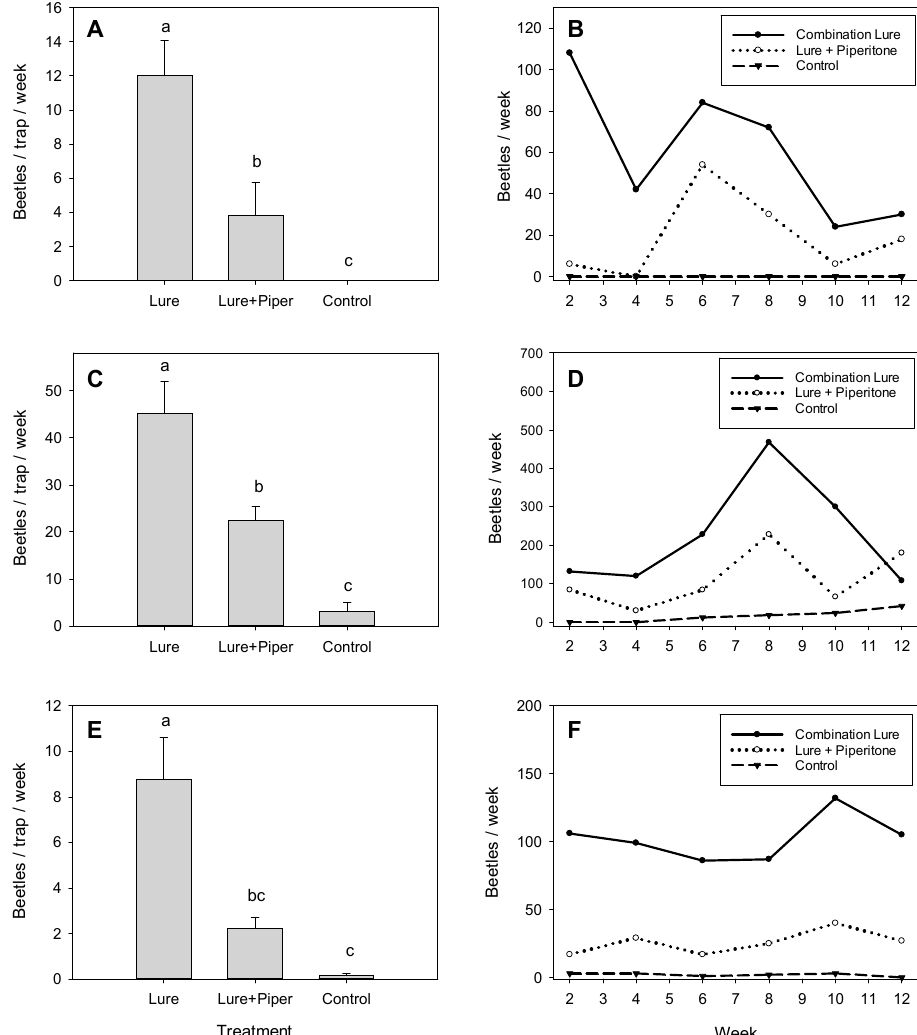
Figure 3. Captures of female Euwallacea perbrevis in replicate 12-week field tests evaluating efficacy and longevity of piperitone repellency in three commercial avocado groves, Miami-Dade County, FL, USA. ( A ) Mean (±SE) captures and ( B ) summed weekly captures in field test 1; ( C ) mean (±SE) captures and ( D ) summed weekly captures in field test 2, and ( E ) mean (±SE) captures and ( F ) summed weekly captures in field test 3. Treatments consisted of sticky panel traps baited with a combination lure (quercivorol and α -copaene), traps baited with a combination lure plus piperitone, and non-baited control traps. For panels ( A , C , E ), bars topped with the same letter are not significantly different (Tukey’s HSD mean separation, p < 0.05).